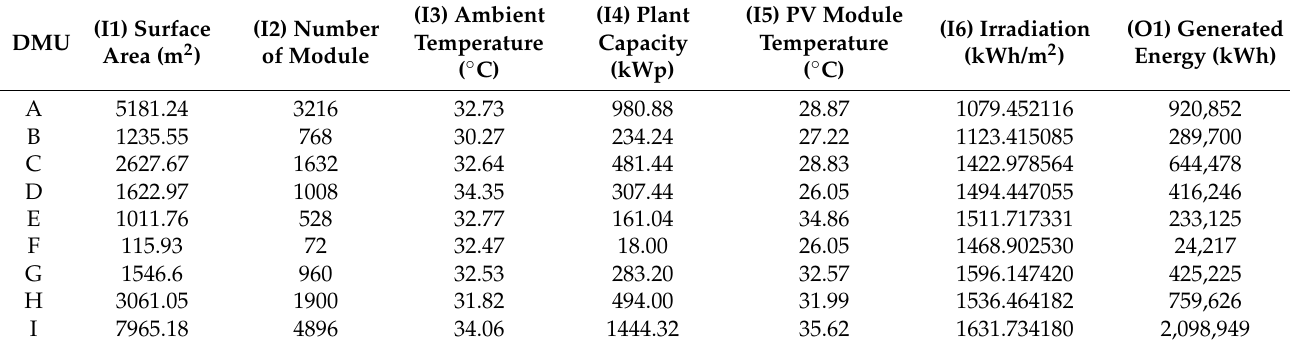
Table 2. Input and output